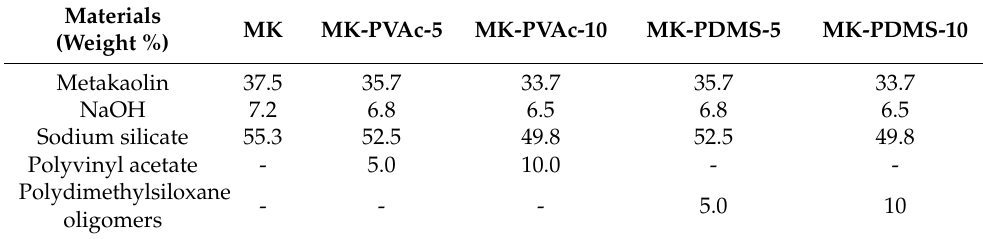
Table 2. Mix design of the geopolymeric samples studied in this